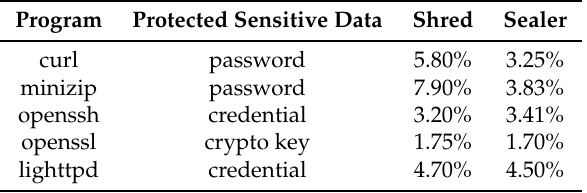
Table 3. Slowdown of programs with